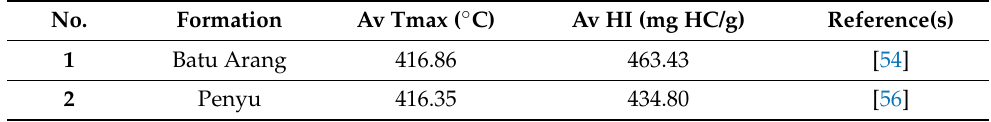
Table 4. Average Tmax and HI values of Batu Arang and Penyu formations in